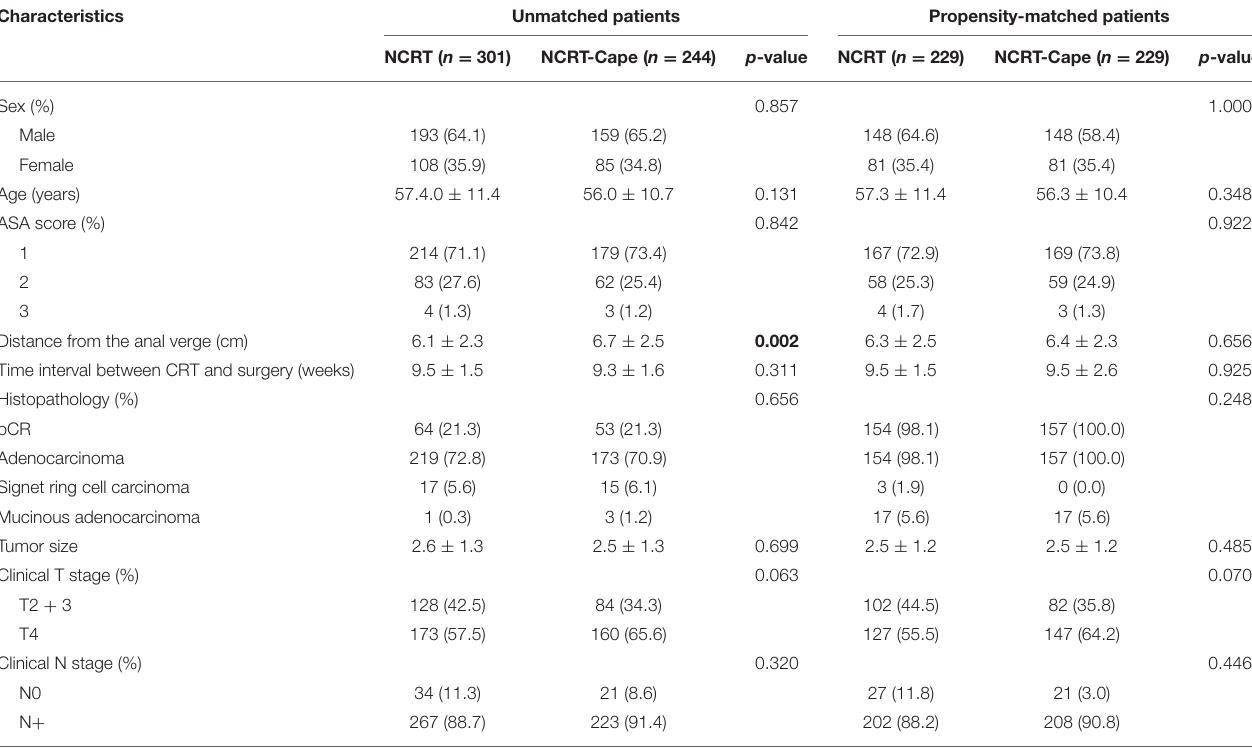
TABLE 1 | Patient characteristics in patients with LARC after NCRT.